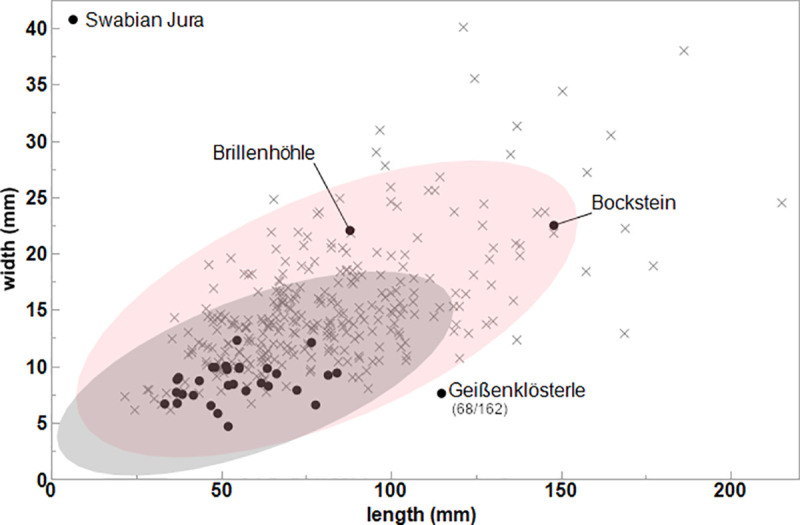
SBPs’ length and width (N = 302) from Europe (Spain, France and Belgium) and SBPs (N = 33) from the Swabian Jura represented by the cross with 95% confidence interval of standard deviations (other measurements from [100]).One piece (Geißenklösterle 68/162) lies outside of the confidence interval of the SBP dimension relative to other European specimens.